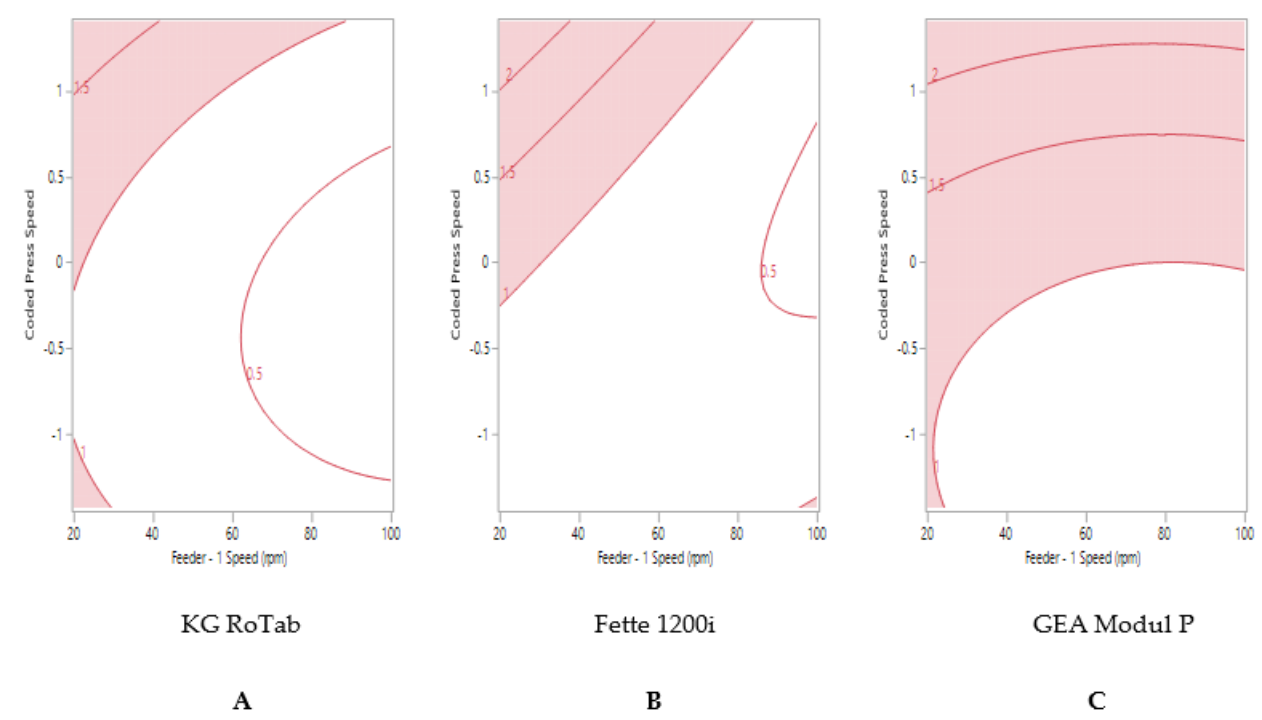
Figure 3. Two-dimensional contour profile showing optimum tablet press speed and feeder speed settings (uncoloured) for formulation 2 “fair” to achieve tablet weight variability ≤ 1% RSD on ( A ) KG RoTab, ( B ) Fette 1200i and ( C ) Modul P. Coded press speeds refer to standardized press speed for each tablet press by subtracting the mean press speed from actual press speed and dividing by the standard deviation. Refer to supplementary information (Table S4) for the actual press